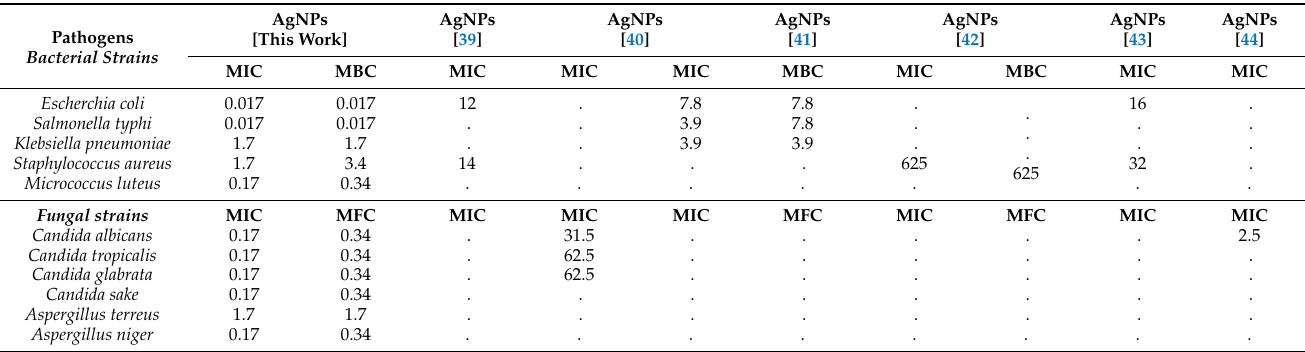
Table 2. Comparative MIC, MBC, and MFC values of the biosynthesized AgNPs from Aeonium haworthii and other published AgNPs. Values are the average from triplicate experiments and expressed in µg/mL.